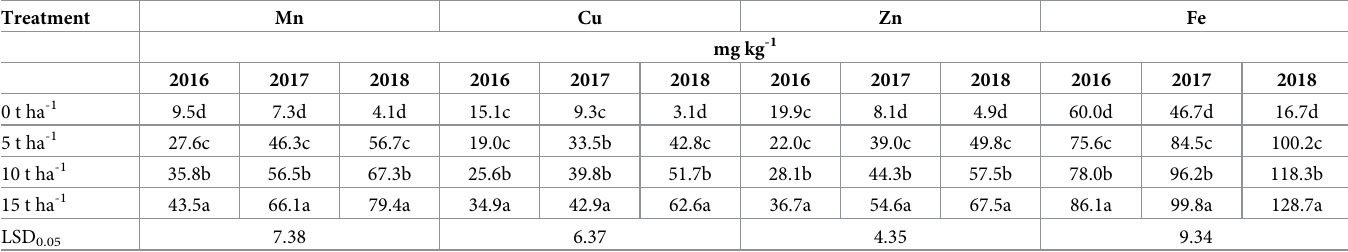
Values followed by the same letter in a column are not significantly (P < 0.05) different.